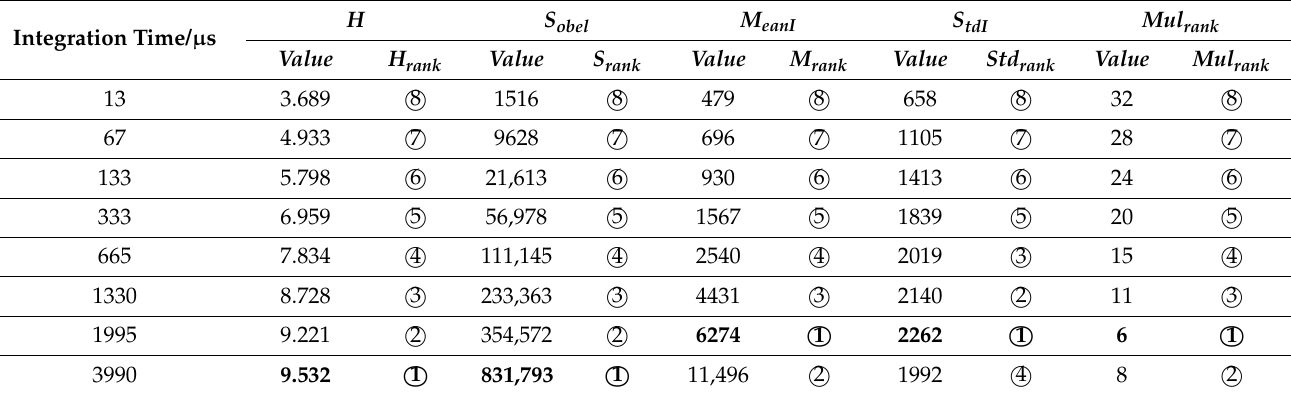
Table 1. Ranking of the four image evaluation indicators for a given